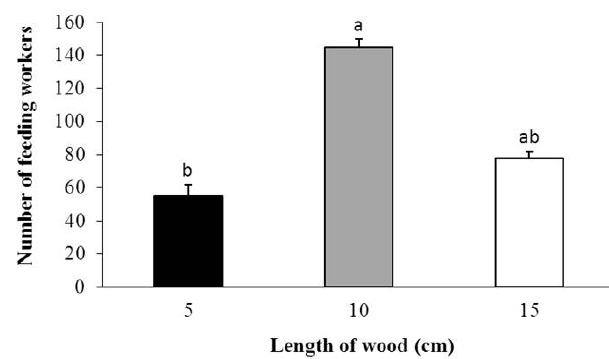
Fig 3 . Number of feeding Nasutitermes corniger workers (average ± SD) after 60 min. of the test (n=20) for the wooden blocks Eucalyptus grandis : 1) 5.0 x 2.5 x 2.0 cm (Size 1); 2) 10.0 x 2.5 x 2.0 cm (Size 2); and 3) 15.0 x 2.5 x 2.0 cm (Size 3). Different letters indicate a significant difference between the treatments based on Tukey’s HSD test, p <